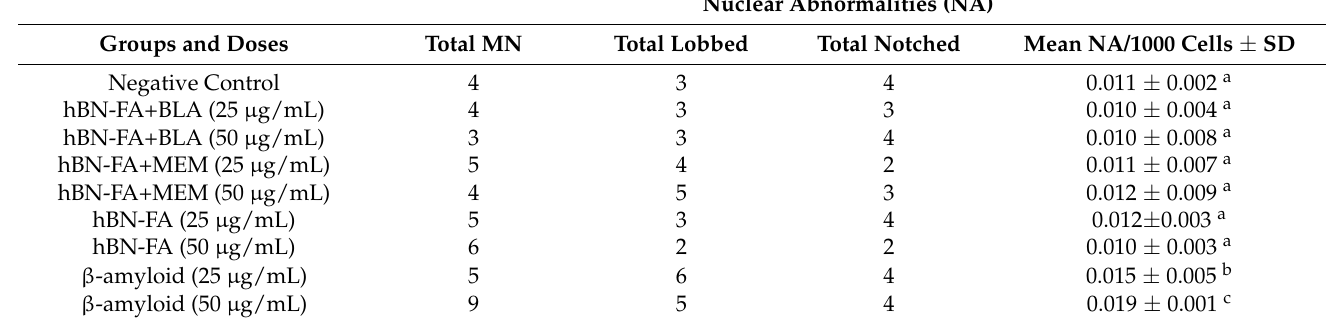
Figure 12. Hoechst 33258 fluorescent staining of differentiated SHSY-5Y cell lines against 25 µ g/mL concentration of hBN-FA+BLA, hBN-FA+MEM and hBN-FA applications for nuclear abnormalities for 24 h (20 × magnifications): ( A ) hBN-FA+BLA; ( B ) hBN-FA+MEM; ( C ) only β -amyloid ( D ) hBN-FA. Table 3. Hoechst 33258 fluorescent staining of differentiated SHSY-5Y cell lines hBN-FA+BLA, hBN- FA+MEM and hBN applications for nuclear abnormalities for 24 h. (Each superscript letter ( a, b, c ) represents statistically similar